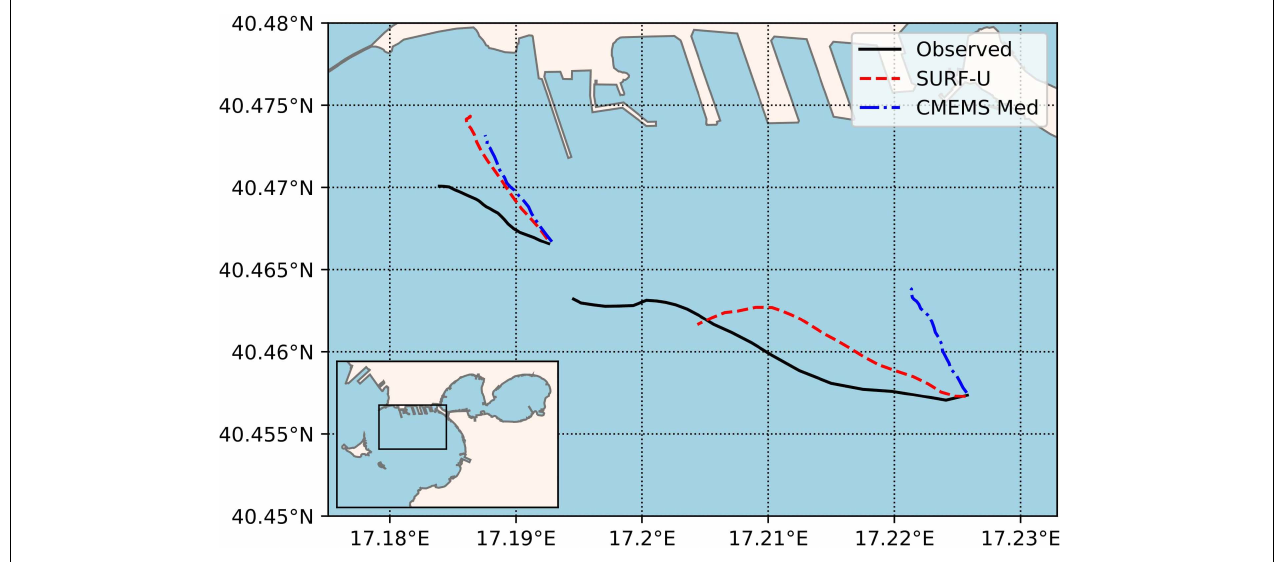
FIGURE 5 | Mean drifter trajectories of the two drifter groups released in the Taranto Sea (black), and simulated drifter trajectories using the SURF-U (red) and CMEMS Med (blue).